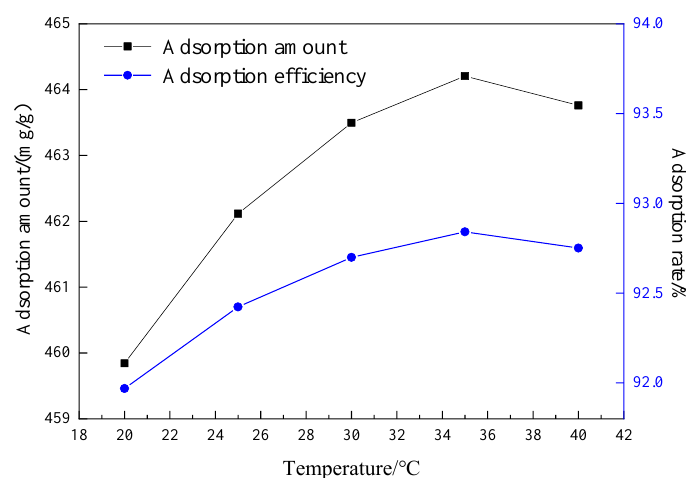
Figure 14. The influence of the temperature on the adsorption effect.